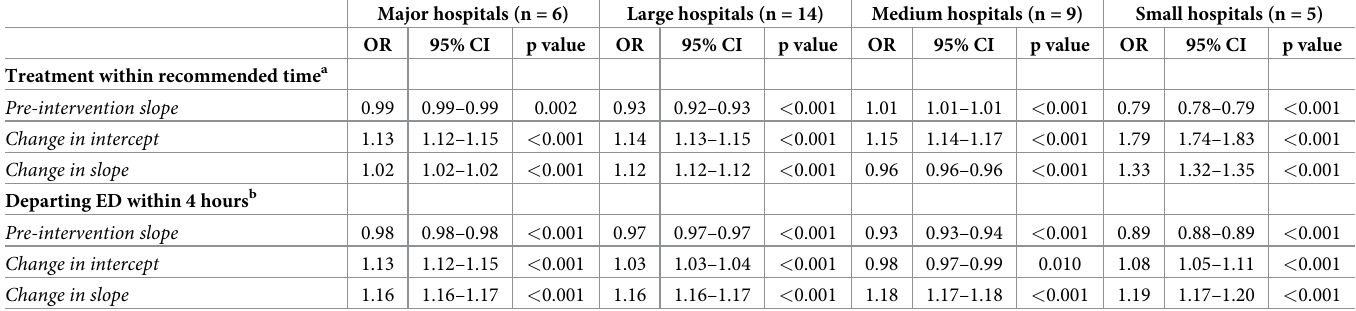
Table 2. Segmented logistic regression models of the relations between government targets, treatment within recommended time, and departing emergency depart- ment within 4 hours stratified by hospital peer